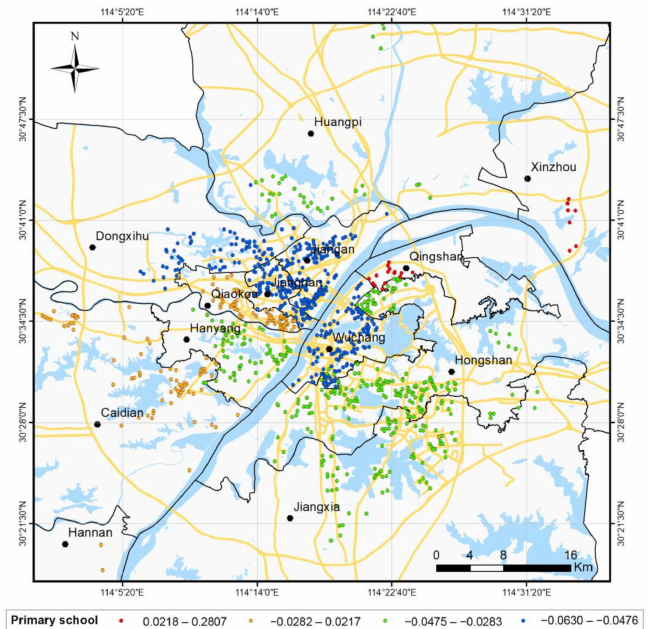
Figure 9. Primary school coefficients map of the study